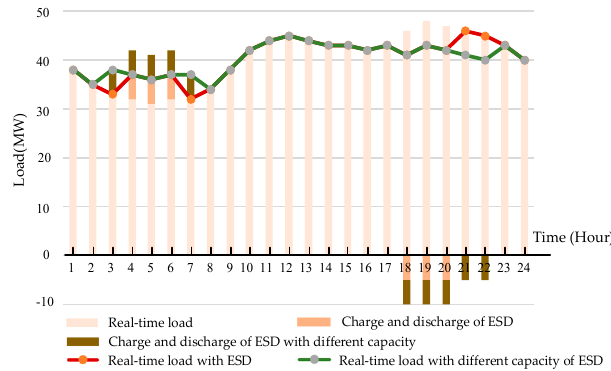
Figure 10. The correlation between load profile variance and charge / discharge rate of ESD.